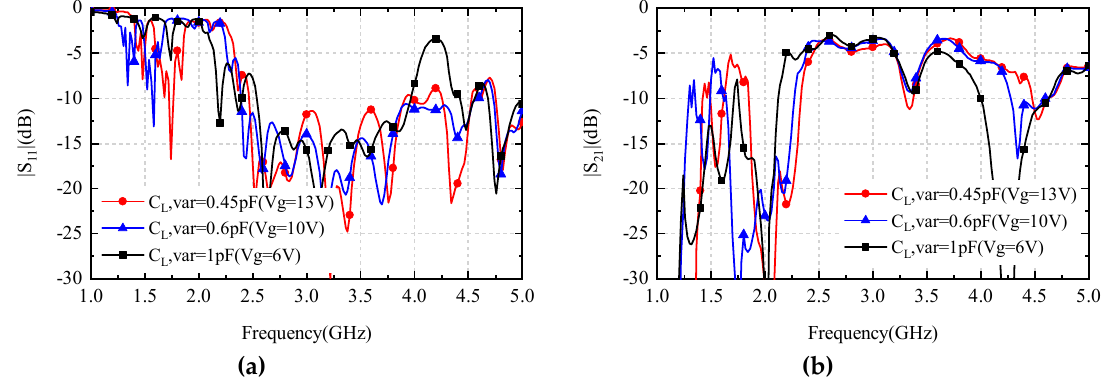
Figure 10. Measured S-parameters of the overall antenna. ( a ) S 11 ; ( b ) S 21 .